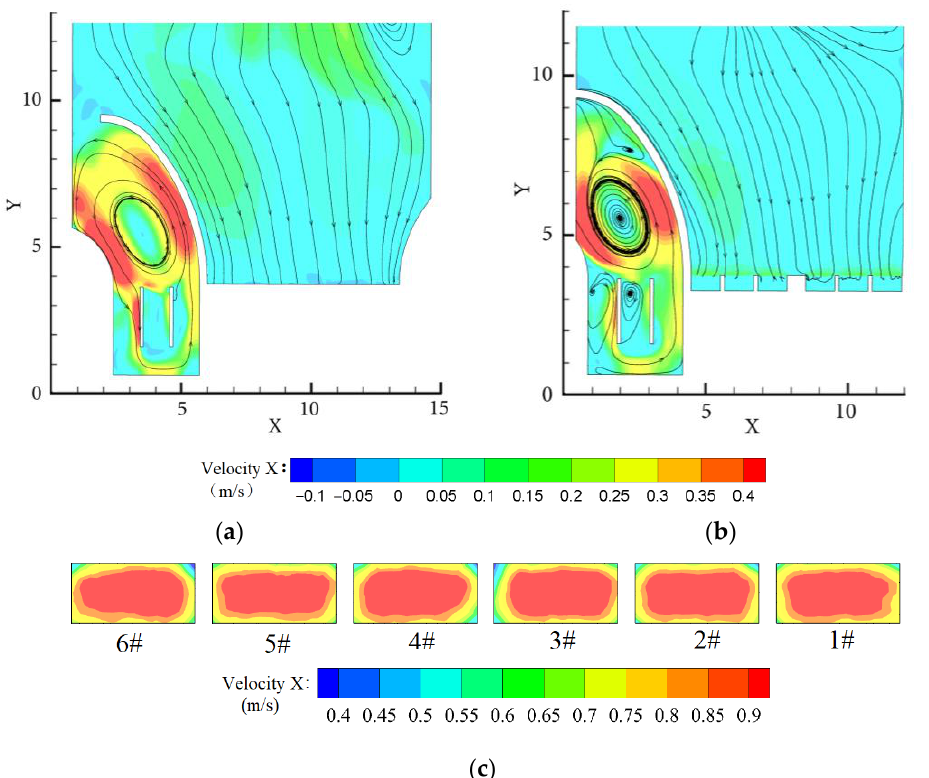
Figure 15. Flow field diagram of each characteristic section in the operational state of pumping: ( a ) flow field distribution of section a-a; ( b ) flow field distribution of section b-b, ( c ) flow field distribution of c-c vertical section.